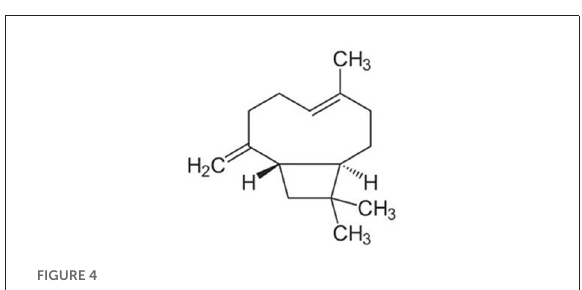
FIGURE3 Chemical structure of Eugenyl acetate .